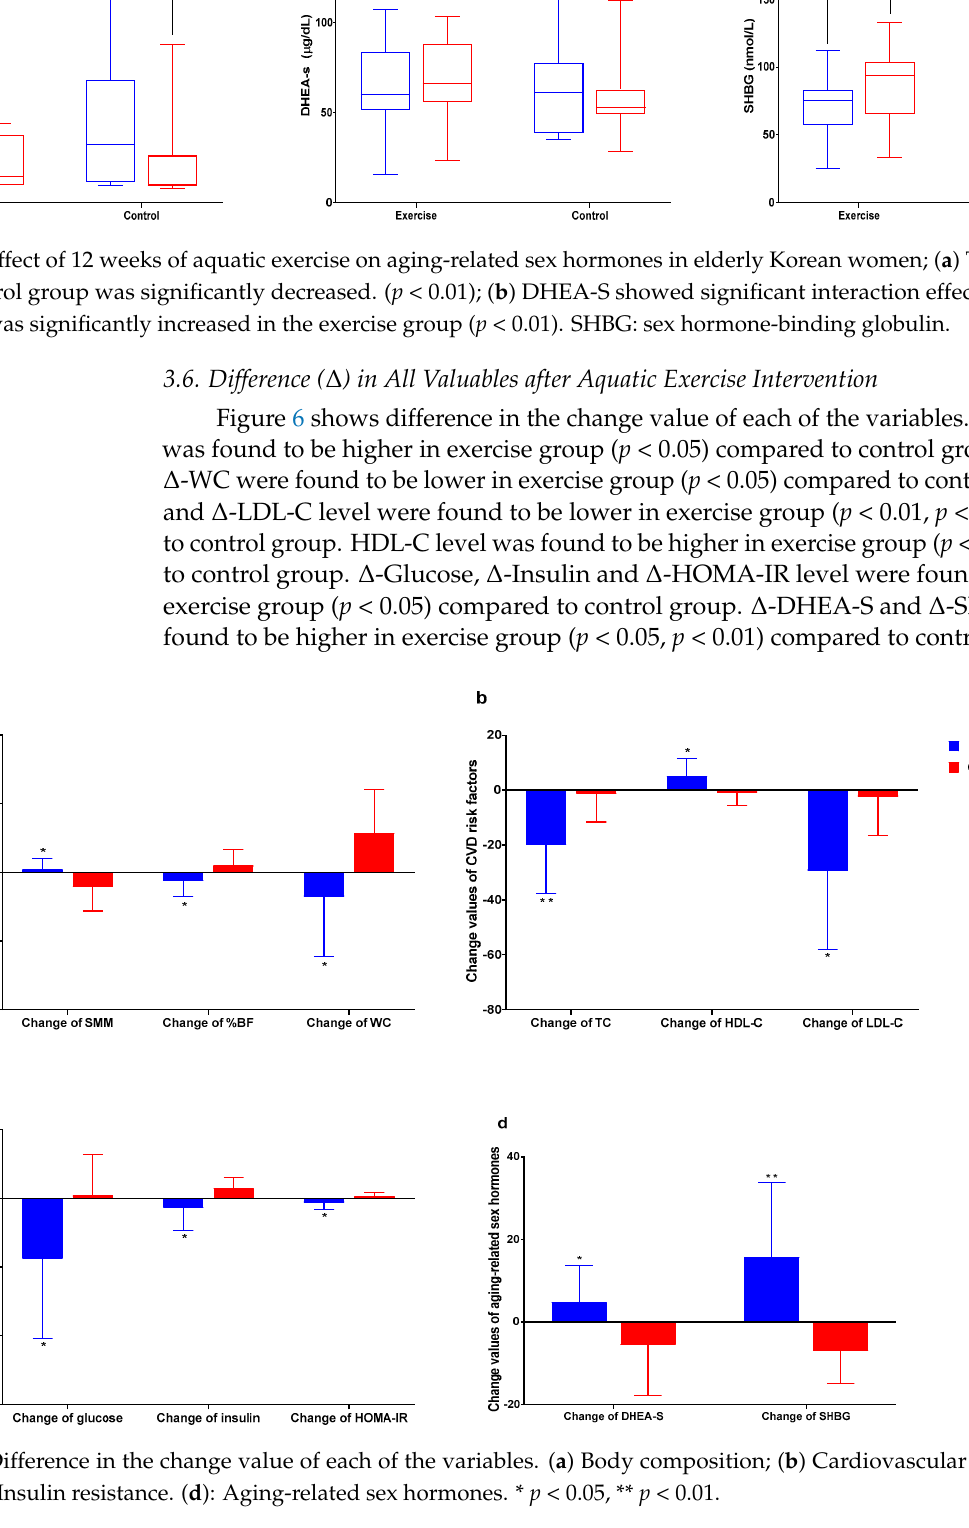
7 of 12 Figure 4. Effect of 12 weeks of aquatic exercise on insulin resistance in elderly Korean women. ( a ) The glucose of the exercise group decreased significantly ( p < 0.01); ( b ) Insulin showed significant interaction effects ( p < 0.05); ( c ) HOMA-IR of the exercise group was significantly decreased ( p < 0.05). HOMA-IR: homeostatic model assessment for insulin re- sistance.